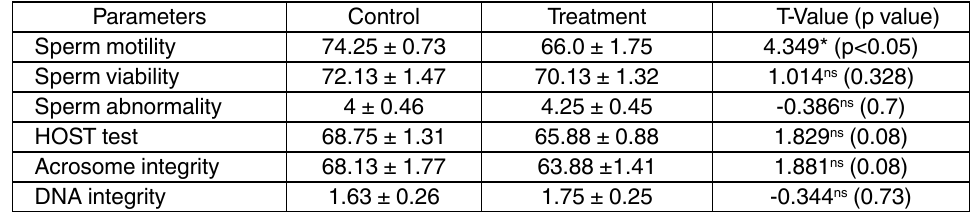
table 3. The effect of glycerol and DMA on pre-freeze semen variables of Malabari buck sperm